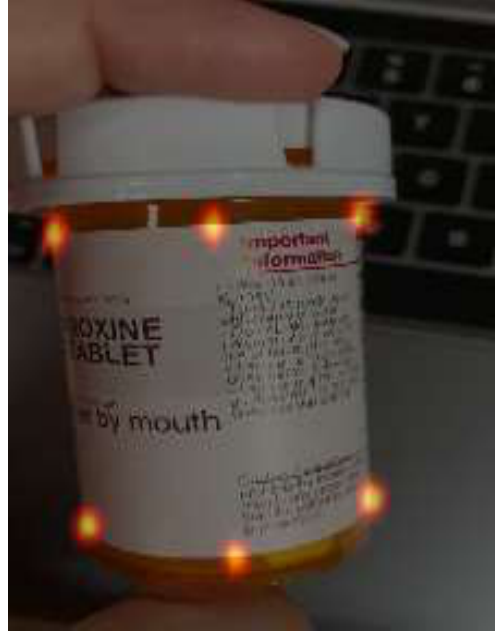
Figure 6. Heatmap for the six-point model.